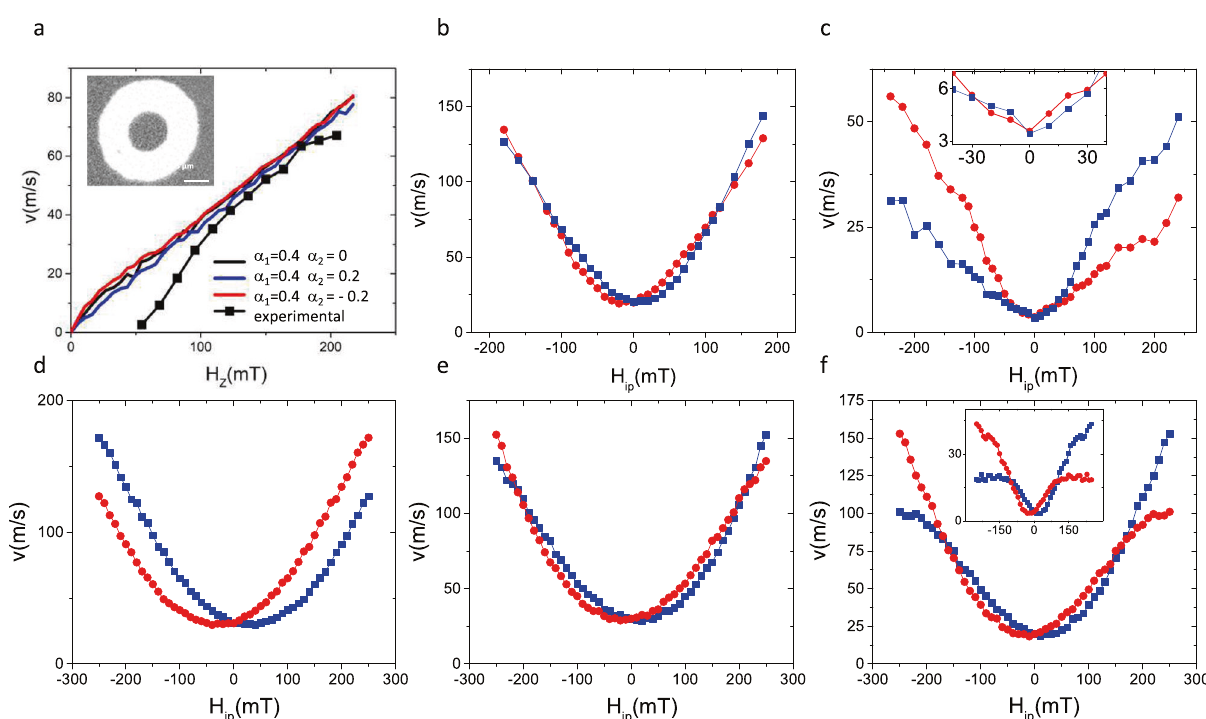
Fig. 3 Field-induced DW motion. a . The experimentally measured DW velocity as a function of H Z (black symbols). The lines are the results of the model with DMI only (black) or including α c (blue and red). The model reproduces accurately the velocity data in the fl ow regime (the region with constant DW mobility). The inset shows a typical differential Kerr image. The bright ring represents the DW displacement produced by the fi eld pulse. b . Measured DW velocity vs. H ip (red for down/up DW, blue for up/down DW, see Fig. S8 for detailed Kerr images) at constant H Z = − 82 mT and c . H Z = − 55 mT. The inset is a zoom of the low fi eld region where the crossing of two curves occurs. d , e , f , Calculated DW velocity with (d) H Z = − 82 mT and α c = 0.4; ( e ) H Z = − 82 mT and α c = 0.4 + 0.2·m x . ( f ) H Z = − 55 mT and inset H Z = − 10